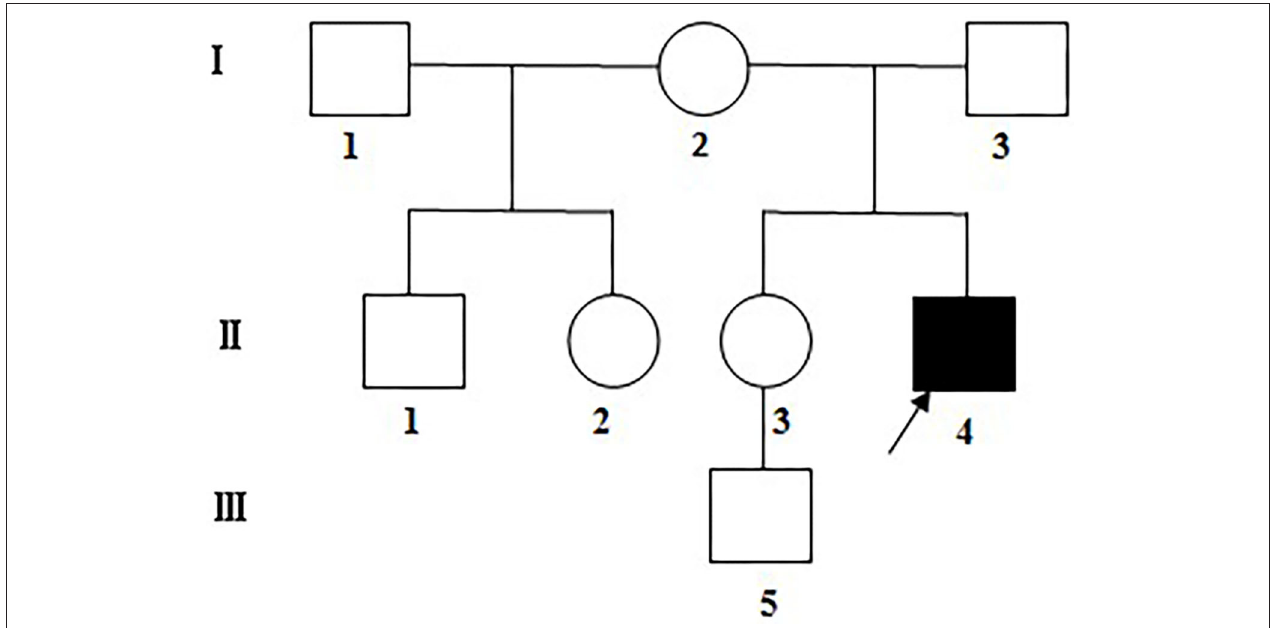
FIGURE 1 | The Chinese LHON family under assessment. Visually impaired family members: filled symbols; females: circles; males: squares; arrow: the